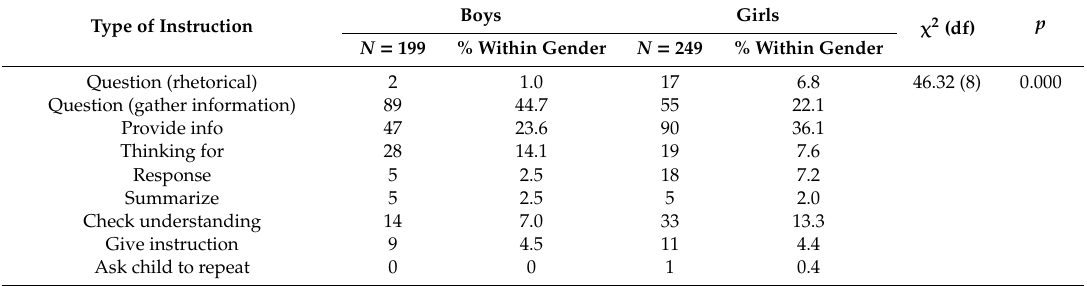
Table 4. Chi-square test of independence of gender and type of instruction from teacher.